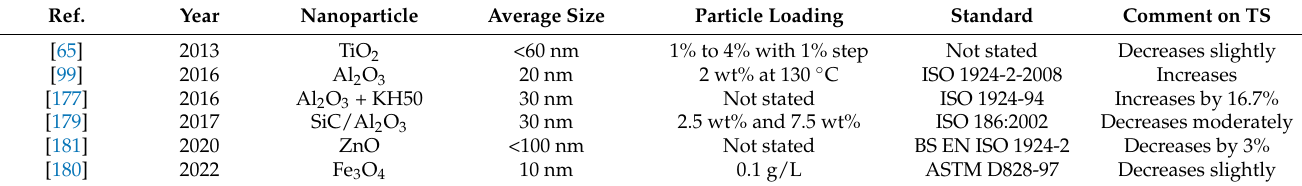
Table 3. Summary of tensile strength (TS) for some cellulose paper modified with nanoparticles.